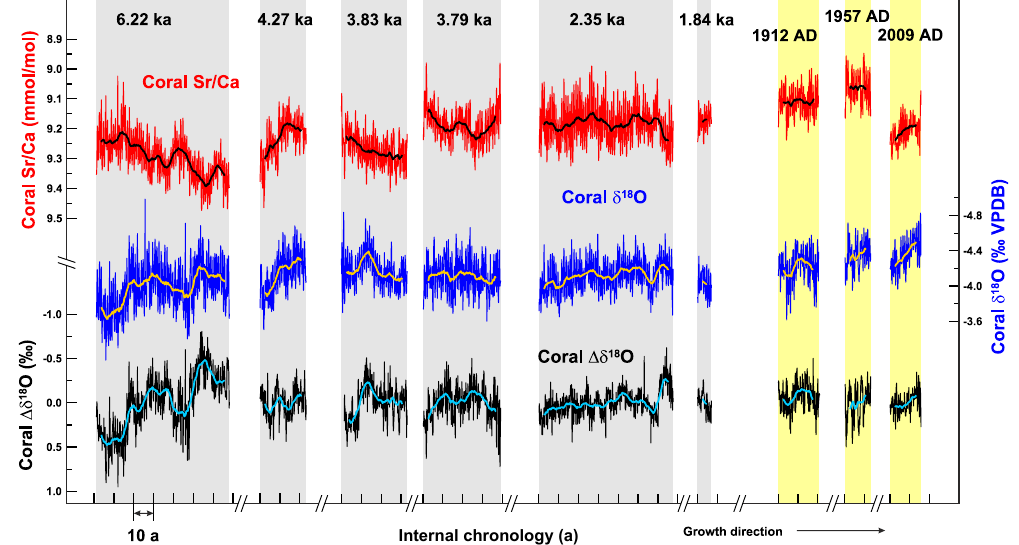
Fig. 2. Monthly resolved coral Sr/Ca (red) (Giry et al., 2012), coral δ 18 O (blue) records and derived coral 1δ 18 O (black) records of modern (yellow shading) and fossil (grey shading) Diploria strigosa corals from Bonaire and corresponding 5-yr running mean. Coral 1δ 18 O records were calculated using the centering method (Cahyarini et al., 2008) and Sr/Ca-SST and δ 18 O–SST slopes of − 0.061mmolmol − 1 ◦ C − 1 and − 0.180‰ ◦ C − 1 (Corr`ege, 2006; Gagan et al., 1998), respectively. The U-series ages of the individual coral colonies (Giry et al., 2012) are